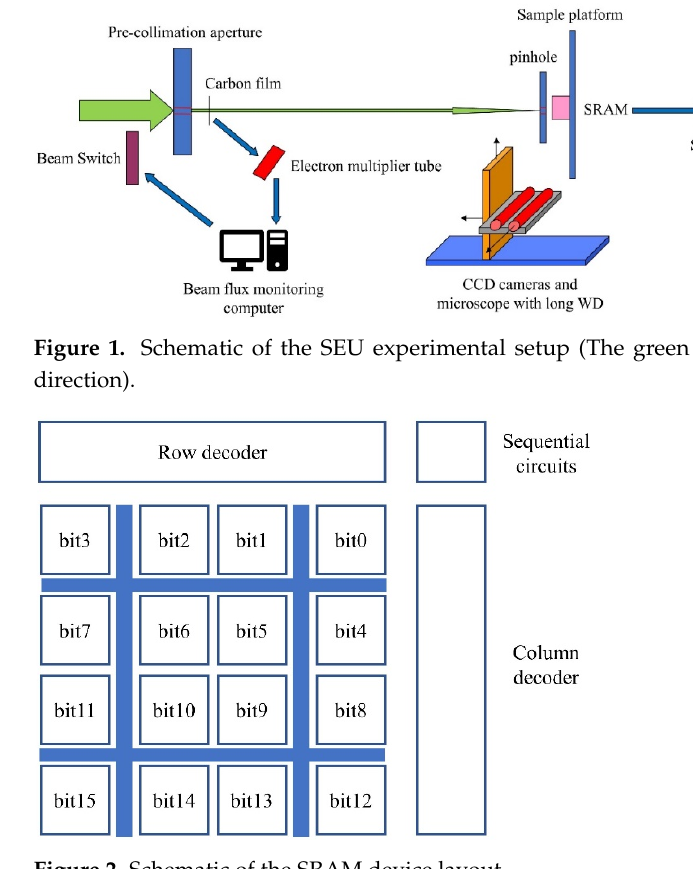
Figure 2. Schematic of the SRAM device layout.